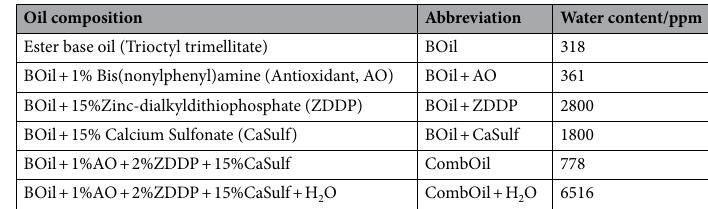
Table 1. Model oil compositions and water content determined by Karl Fischer